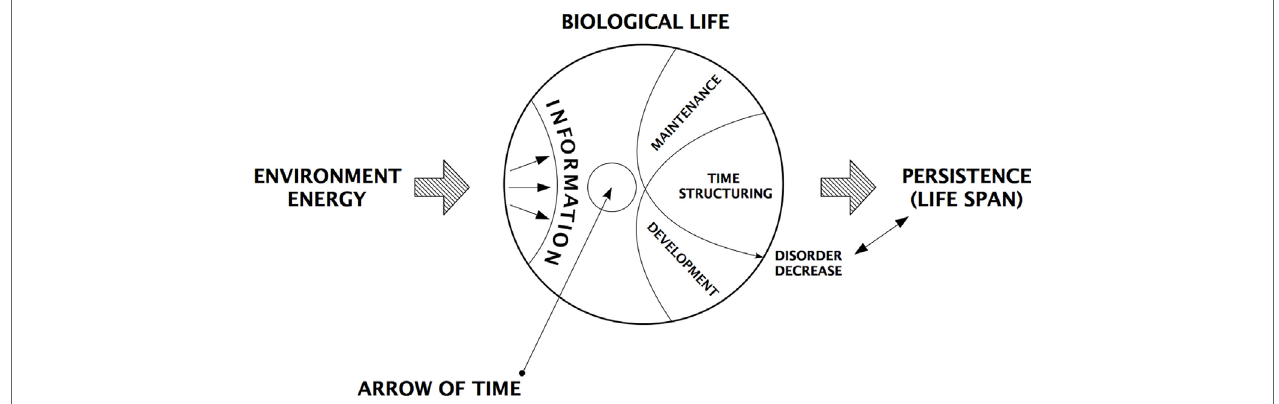
FiguRE 1 | Schematic representation of time structuring that characterizes biological life. The information encoded from the interaction with the environment reduces the level of entropy and make order in the